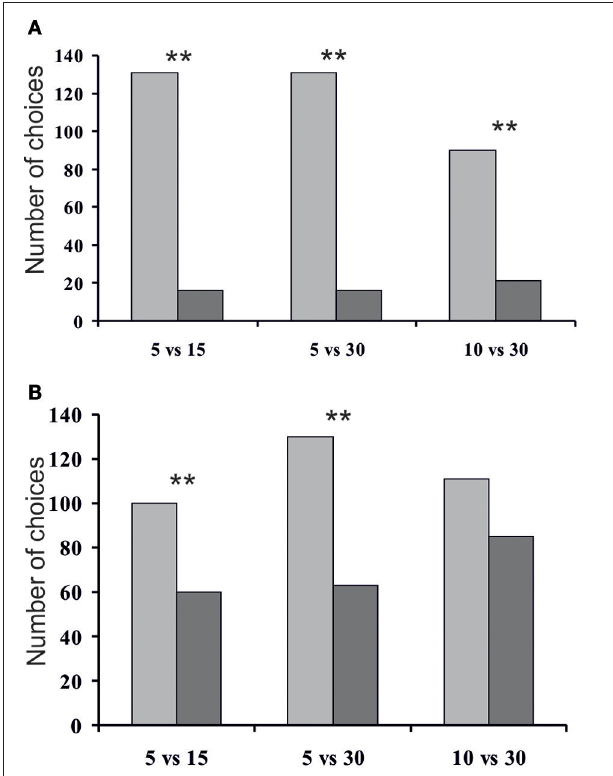
FIGURE 4 | Total number of choices of the tunnels by mice (A) and total number of all cases when mice touched the entrance of the tunnels (B) (** P < 0 . 01 Pearson’s chi-squared